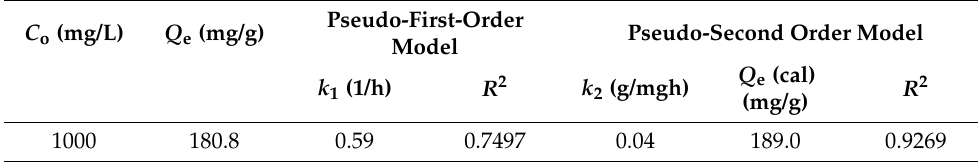
Table 4. Kinetics model parameters of lead molecules on HAP